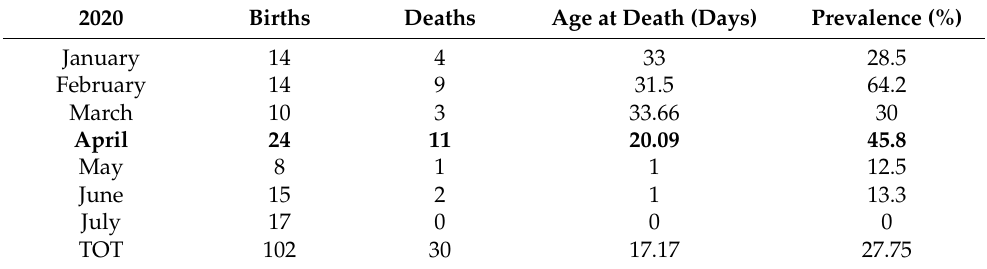
Table 1. Mortality year